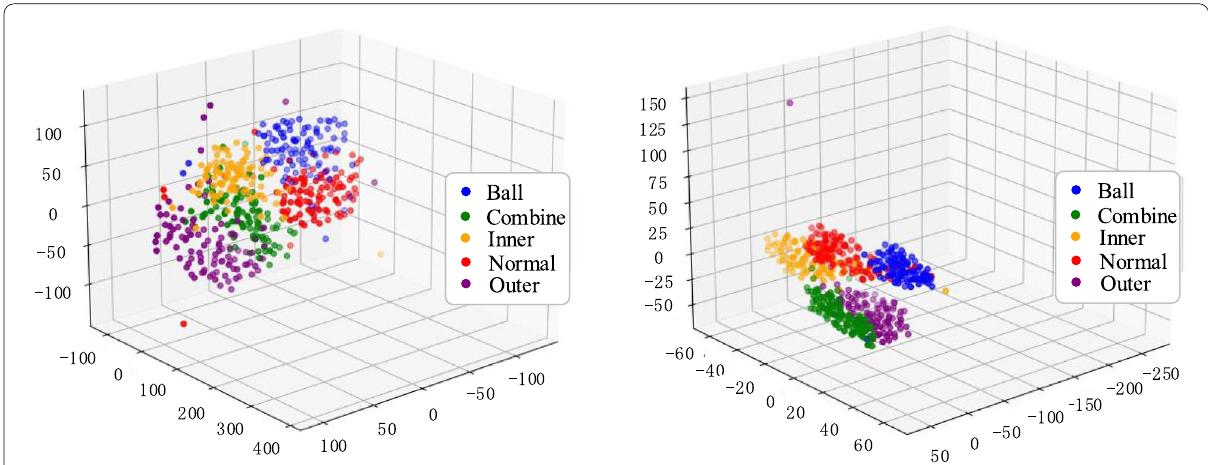
Fig. 13 Visualization of diagnostic results of 1D CNN and ISNN under Training set C. (Left) (a) 1D CNN (Right) (b)